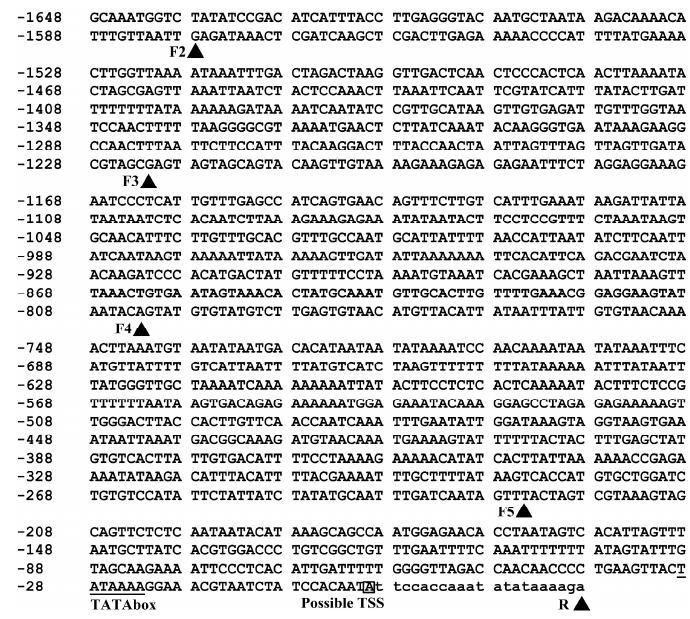
Figure 1. Nucleotide sequence of the 5 ′ -flanking region of PPO gene. Nucleotides are numbered on the left with the possible transcription start site which is designated as +1 and white-boxed. The TATA-box is underlined. The deletion positions are indicated with a black triangle behind the short name of forward (F2 to F5) and reverse (R) primers.